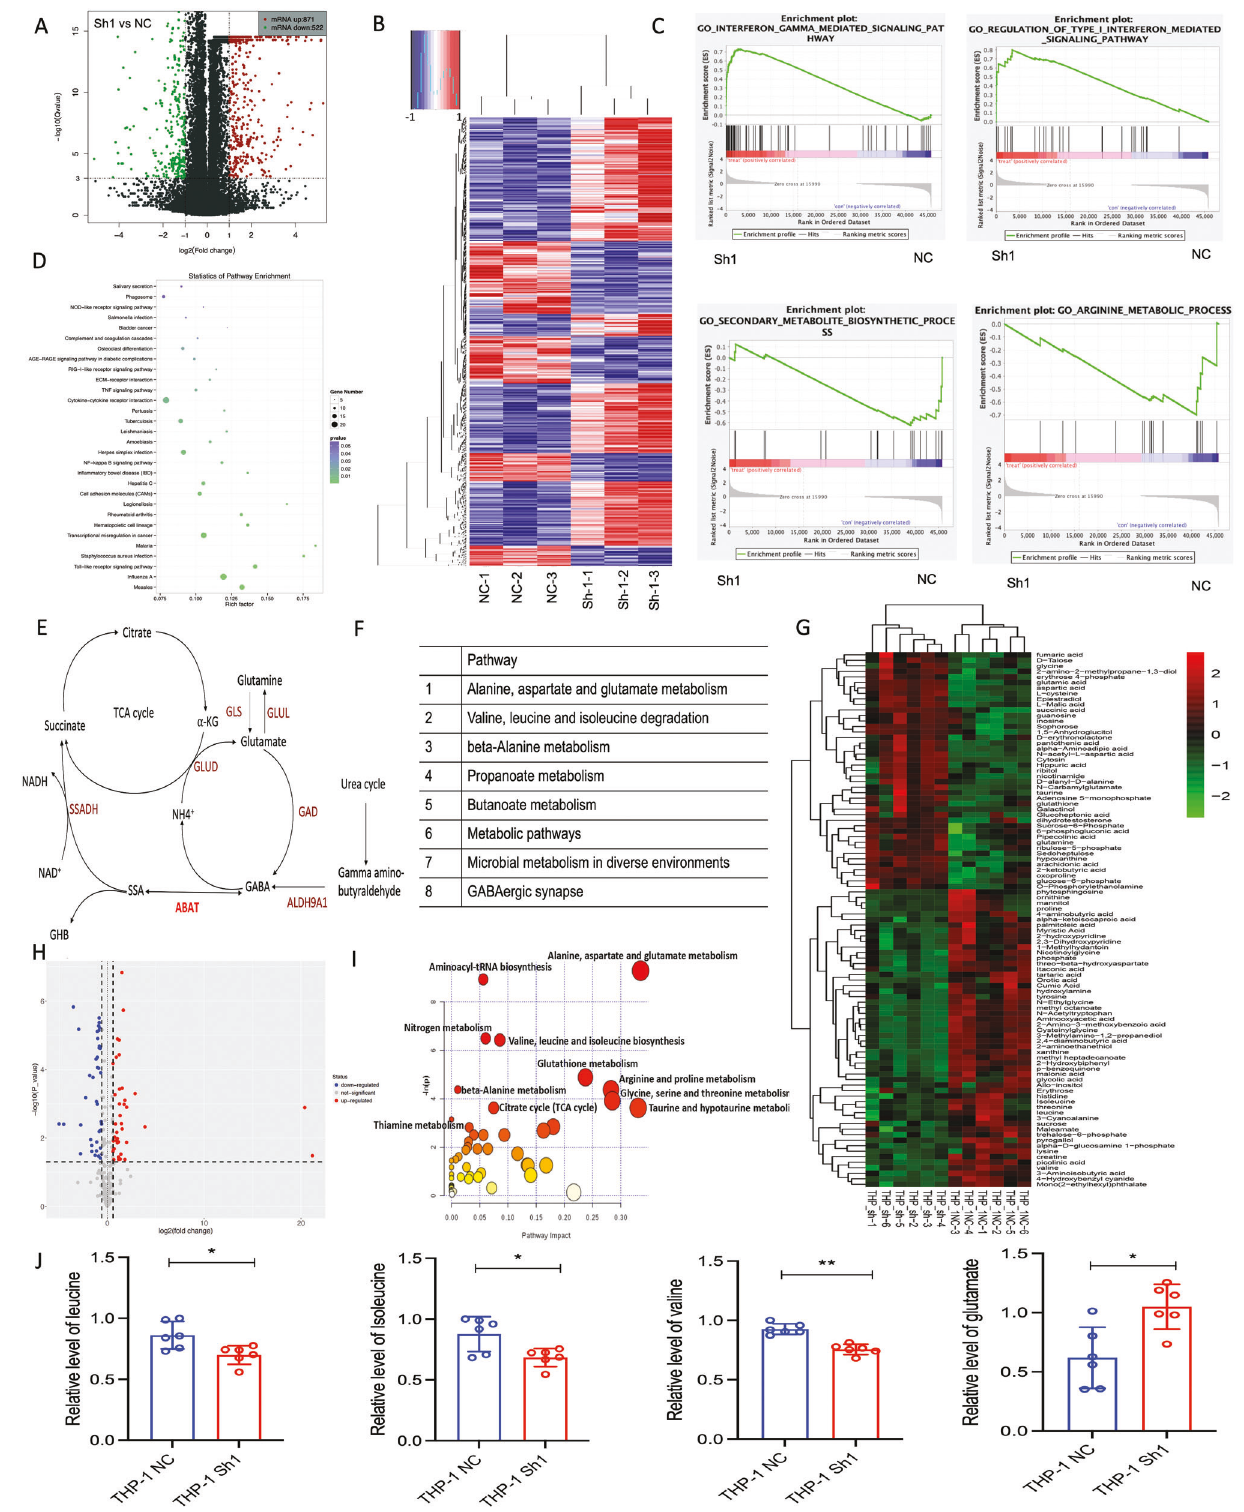
Fig. 3 RNA-sequencing and GC-MS analysis in THP-1 cells with ABAT knockdown. A Volcano map of differential gene expression in THP-1 cells with ABAT interference. B Heatmap of differential gene expression screened in ABAT silenced THP-1 cells. C Gene Set Enrichment analysis of top two upregulated and downregulated pathways. D KEGG pathway analysis of differentially expressed genes. E The metabolic pathway of ABAT gene involved in disease. F ABAT gene-related pathway was analyzed using KEGG. G Heatmap of differential metabolites screened in ABAT silenced THP-1 cells. H Volcano map of differential metabolites in THP-1 cells with ABAT knockdown . I KEGG pathway analysis of differential metabolites. J Representative differential metabolites were analyzed between NC and ABAT knockdown groups. Data were shown as mean ± SEM from three biological samples. * P < 0.05, ** P < 0.01. Student ’ s t -test was used in two-group comparisons.